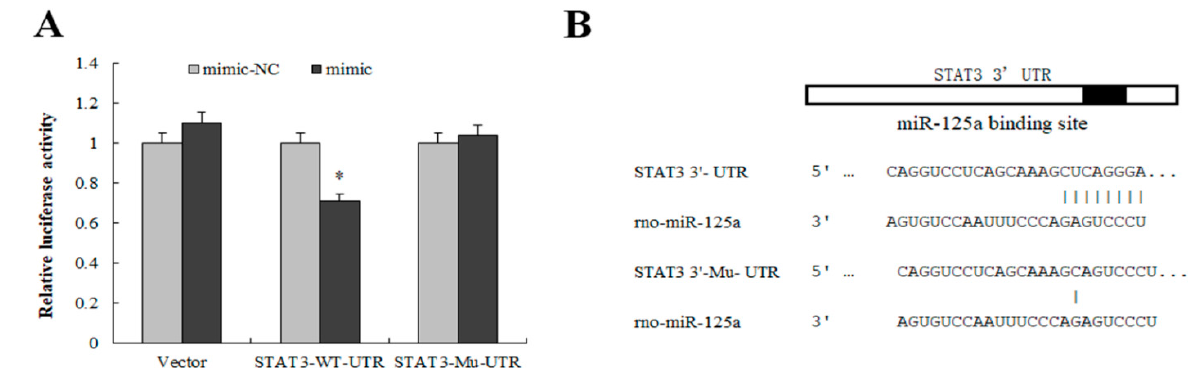
Figure 5. STAT3 was a target gene of miR ‐ 125a. ( A ) Luciferase activity was detected by luciferase report assay after co ‐ transfection of STAT3 ‐ WT/Mu ‐ UTR as well as miR ‐ 125a mimics and NC report assay after co-transfection of STAT3- WT/Mu -UTR as well as miR-125a mimics and NC mimics in BRL ‐ 3A. ( B ) The binding site of miR ‐ 125a and STAT3 ‐ WT/Mu ‐ UTR. Data are shown as mimics in BRL-3A. ( B ) The binding site of miR-125a and STAT3- WT/Mu -UTR. Data are shown as mean ± SEM, * p < 0.05. mean ± SEM, * p < 0.05. Table 2. Functional enrichment analysis of the predicted target genes of miR ‐ 125a.